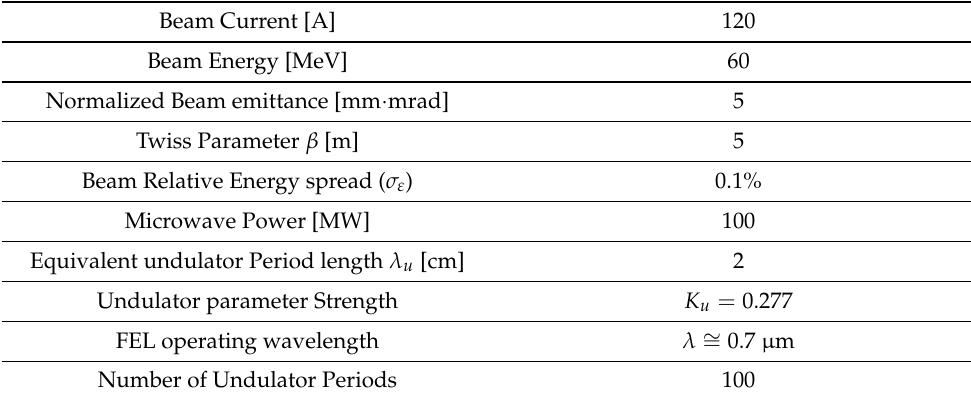
Figure 6. ( a ) g 0 vs. microwave power (MW) for different values of the beam energy (dash 50 MeV, continuous 100 MeV) x = 1 √ ; ( b ) g 0 vs. the beam energy for different values of the microwave 2 power (dashed line 100 MW, solid line 300 MW); ( c ) g 0 vs. FEL resonant wavelength ( x = 1/ P = 100 MW), for the remaining parameters see Table 1. Table 1. Sub-micron MU-FEL oscillator design